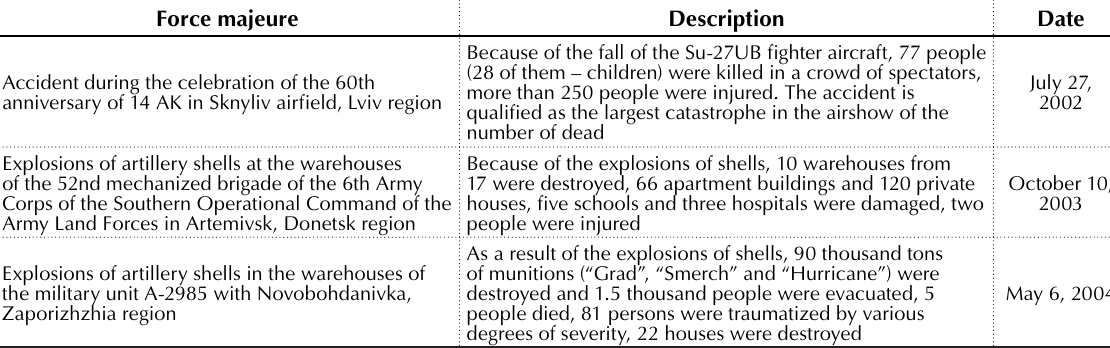
Table D1. The main technological disasters in Ukraine during 1991–2018